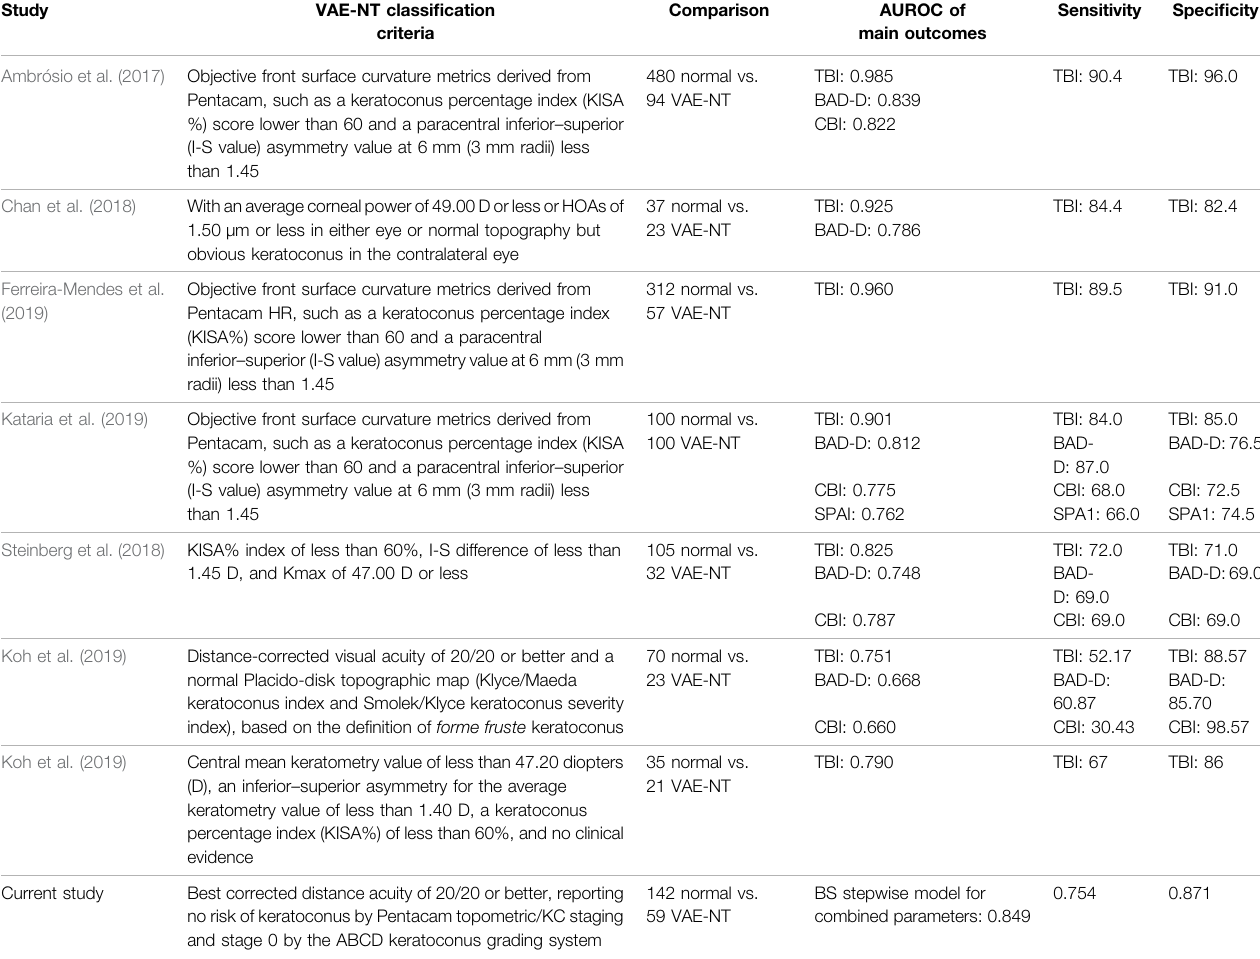
TABLE 3 | Comparison of VAE-NT classify criteria and AUROC of the main outcome measures with previous studies. Study VAE-NT classi fi cation